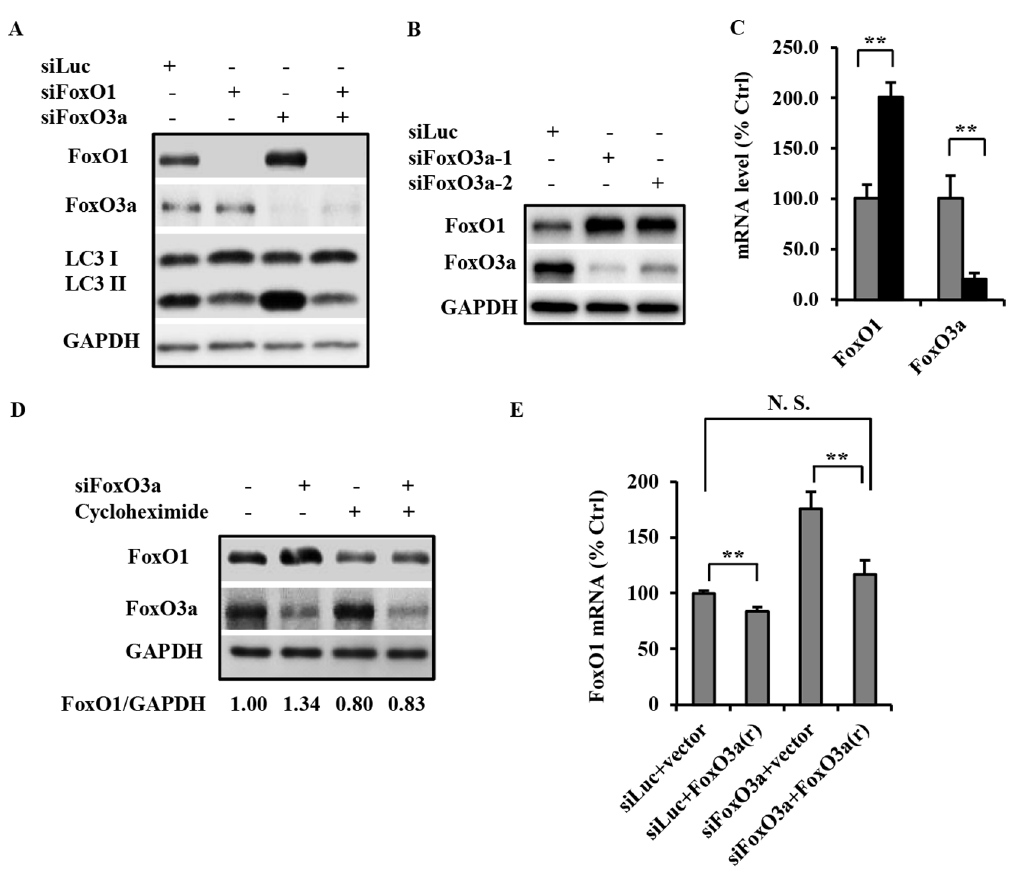
Fig. 4. FoxO3a negatively regulates autophagy through inhibition of FoxO1 transcription. (A) PC3 cells were transfected with siRNA for luciferase (siLuc), FoxO1 (siFoxO1), or FoxO3a (siFoxO3a), or combinations, as indicated. Cells were harvested 72 h after transfection, and cell lysates processed for immunoblot analysis of the indicated proteins. (B) FoxO3a knockdown with two FoxO3a targeting siRNA to illustrate the impact on FoxO1 protein level. (C) Real-time PCR analysis of FoxO1 and FoxO3a mRNA levels in control siRNA (gray) or FoxO3a siRNA (black) transfected cells. Cells were harvested and processed 48 h after transfection; 18S ribosomal RNA was analyzed as the normalization control. Data was presented as Mean ¡ S.D. (‘‘**’’, p , 0.01). (D) PC3 cells were transfected with control siRNA or FoxO3a siRNA as indicated. Following 48 h of transfection, cells were treated with either DMSO control or 10 m g/ml cycloheximide for 24 h as indicated prior to being harvested for immunoblot analysis of the indicated proteins. The FoxO1/GAPDH ratio for each condition is as presented after band quantification by ImageJ. (E) Real-time PCR analysis of endogenous FoxO1 expression level in PC3 cells transfected with either control plasmid (vector) or that expressing FoxO3a(r); in each group of the plasmid transfected cells, either control siRNA or FoxO3a siRNA were concurrently introduced. The cells are harvested for RNA preparation and q-PCR analysis 72 h post transfection; FoxO1 transcript levels were analyzed, as described in Experimental Procedures. 18S was used as the normalization control. Data was presented as Mean ¡ S.D. (‘‘**’’, p , 0.01). All experiments have been performed three times with similar